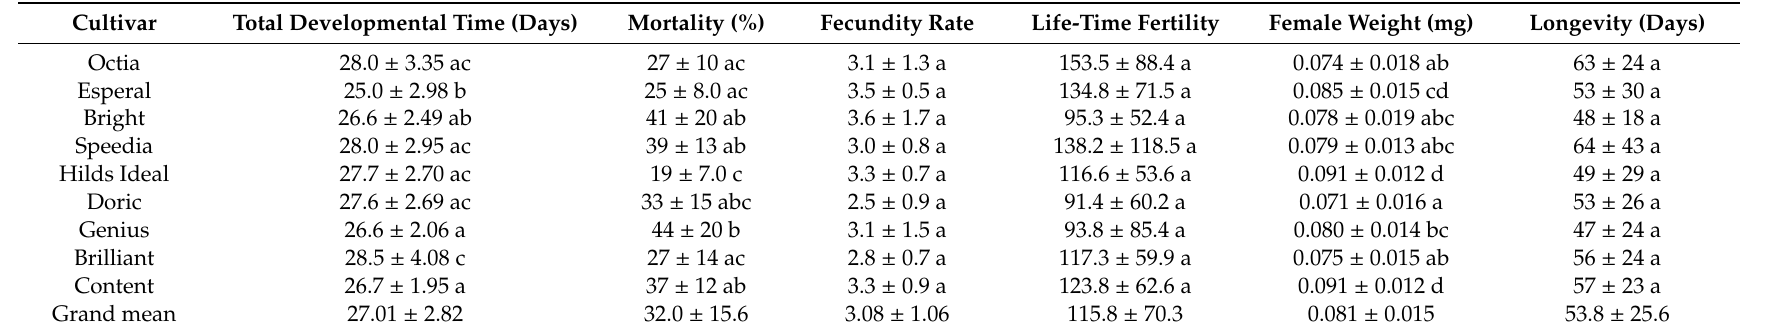
Table 1. Results of antibiosis experiments, including developmental time (egg to adult), mortality (combined egg and larval), fecundity rate (number of eggs per day and female), life-time fertility (number of o ff spring per female over whole lifetime), female weight (hatched adults), and longevity of females (means ± SD) of